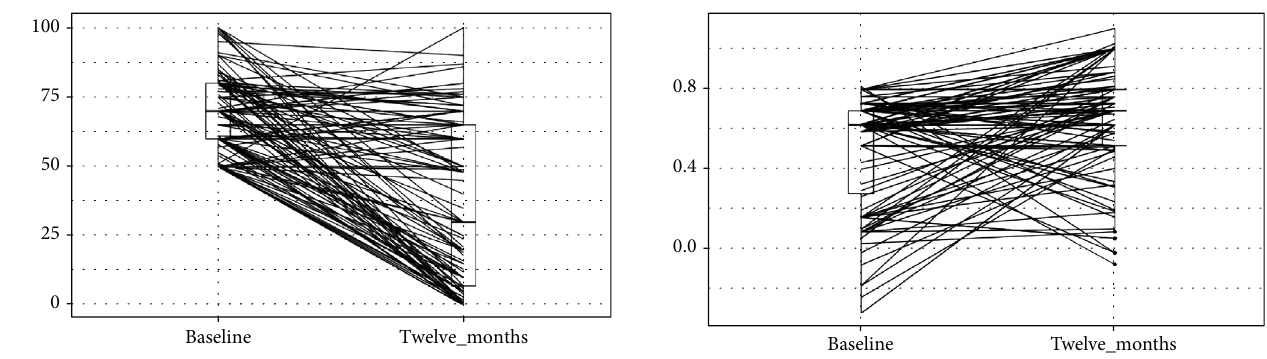
Figure 1: VAS scores at baseline and at twelve months follow-up. y -axis: Visual Analogue Scale (VAS) for pain value; boxplot showing L-estimators: maximum (100), minimum (50), median (70), and interquartile range (20); outliers plotted as individual points at baseline and maximum (100), minimum (0), median (30), and interquartile range (58); outliers plotted as individual points at 1 year follow-up. x -axis: Visual Analogue Scale (VAS) for pain at preoperative baseline and at twelve months follow-up. Connecting lines: heuristic visualization of single-patient trajectories of variation of Visual Analogue Scale (VAS) value for pain between preoperative baseline and twelve months follow-up; plotted with R (version 4.0.0 or higher; libraries ggpubr and PairedData). Source: Authors ’ Data and reproducible statistical analysis with Open